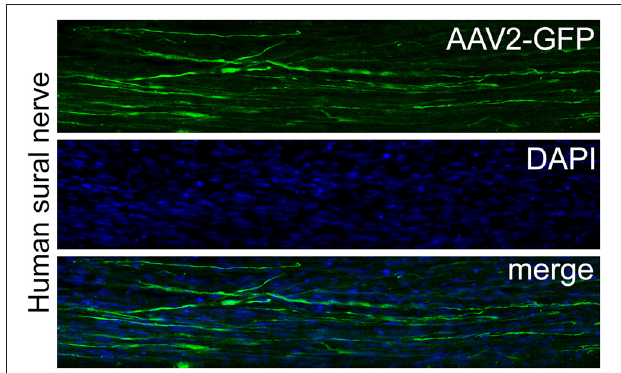
FIGURE 2 | AAV2-mediated transduction of a human sural nerve segment. Surplus human nerve material was obtained from the operation room and anonymized as stated in the code of conduct for responsible use of human tissue and medical research (Federa, 2011). Nine AAV serotypes were compared for their transduction efficiency by injecting 1.85 × 10 10 gc/cm nerve and culturing the nerve segments for 14 days. After 14 days nerve segments were immersion fixed with paraformaldehyde and 20 µ m sections were prepared. The upper panel show a section through a human sural nerve stained for GFP. The middle panel shows the same image stained for the nuclear stain Hoechst and the lower panel shows the merged images of the two panels. AAV2 transduced numerous cells that display the typical longitudinal shape of Schwann cells and this serotype was superior to all other serotypes tested. More details on this study can be found in Hoyng et al.